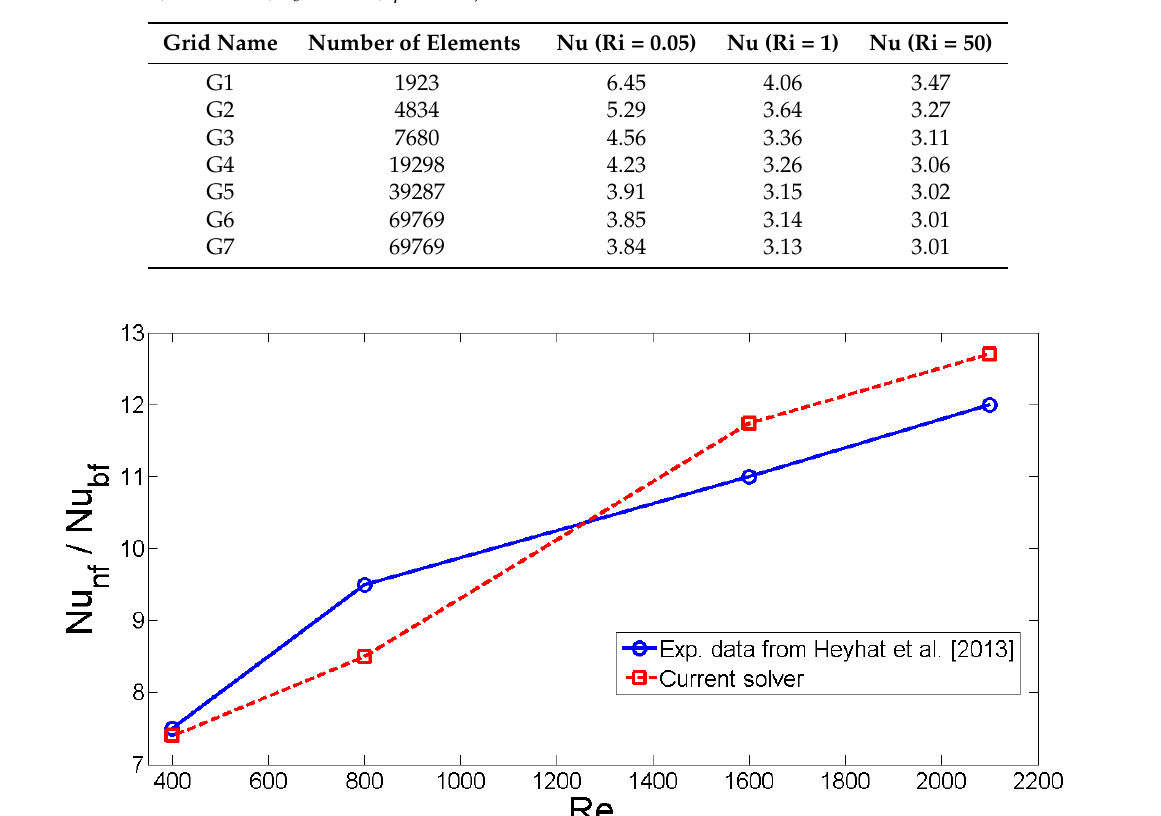
Table 2. Grid independence test results for three different values of Richardson numbers (Ha = 50, Da = 10 − 2 ,